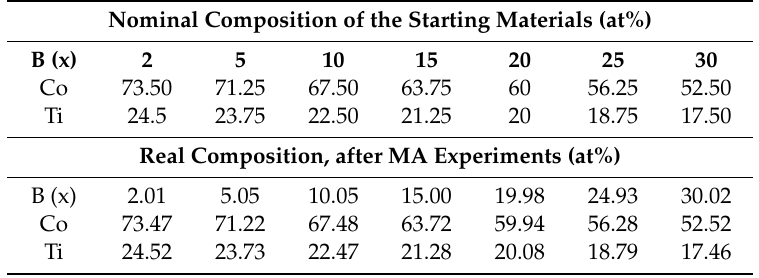
Nominal Composition of the Starting Materials